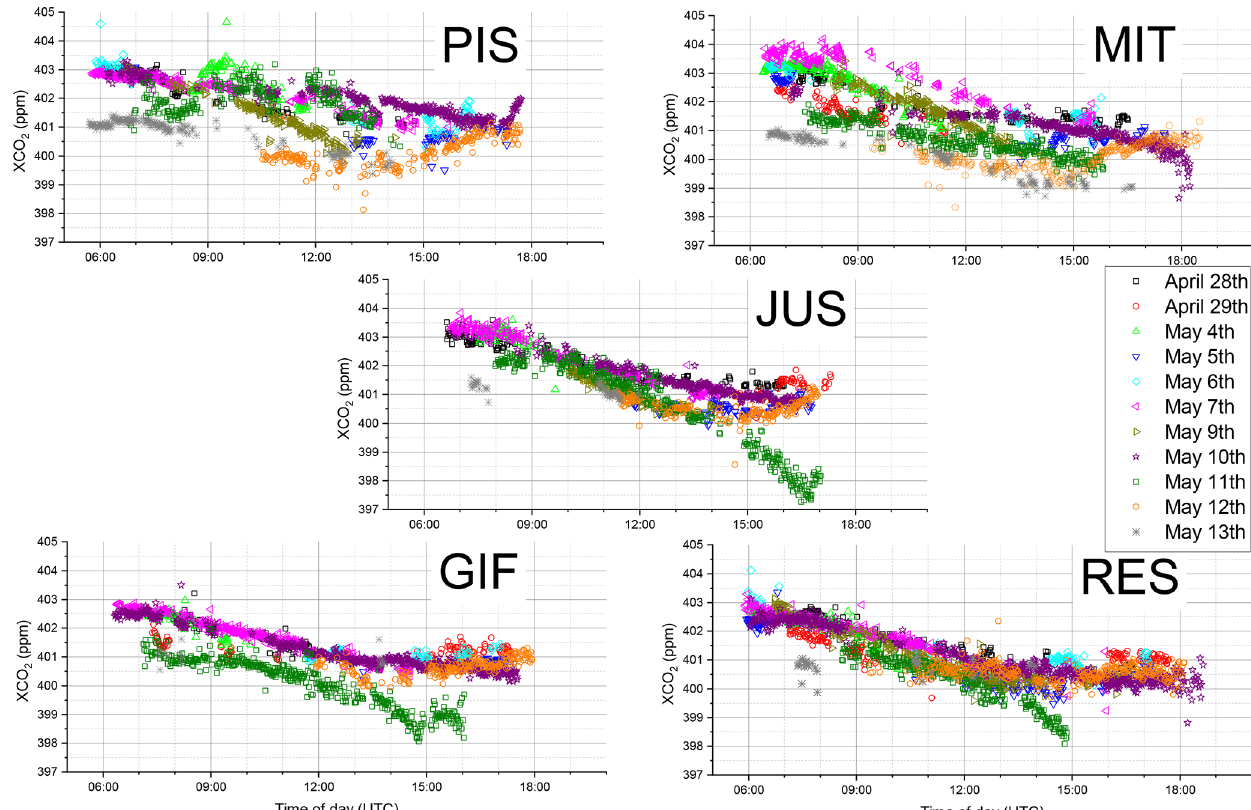
Figure 3. Time series of observed XCO 2 in the Parisian region sorted by